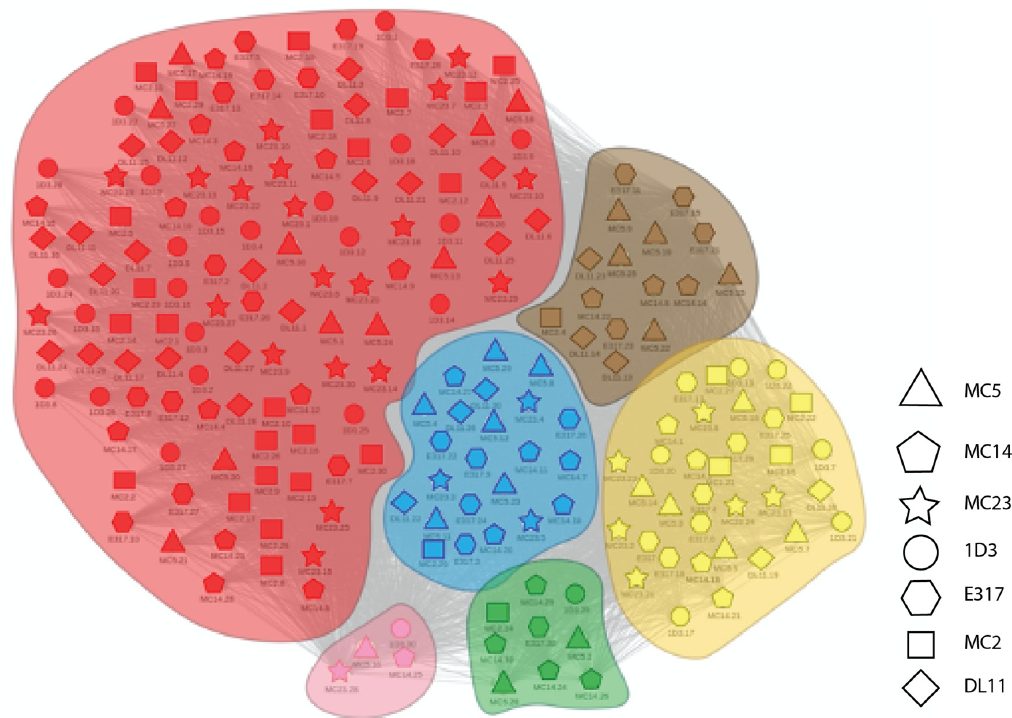
Figure 5. Community map of docking models for Abs vs. gD2. Nodes represent docking models, with different symbols for the different Abs. Edges indicates structural competition between pairs of docking models. Colors and background shading indicate community membership according to the partitioning of a dendrogram. The shape of each marker indicates the antibody in the dock (i.e. each shape is a single antibody).